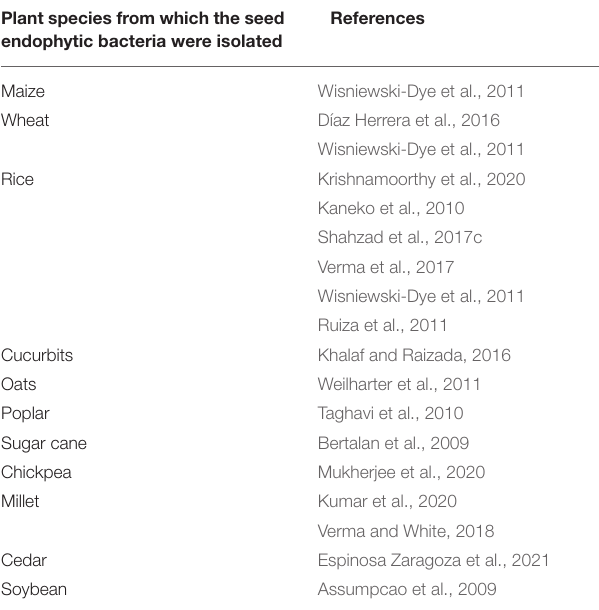
TABLE 1 | Summary table of publications recording the ability of seed endophytic bacteria of several cultivated plant species to produce indole acetic acid. Plant species from which the seed endophytic bacteria were isolated